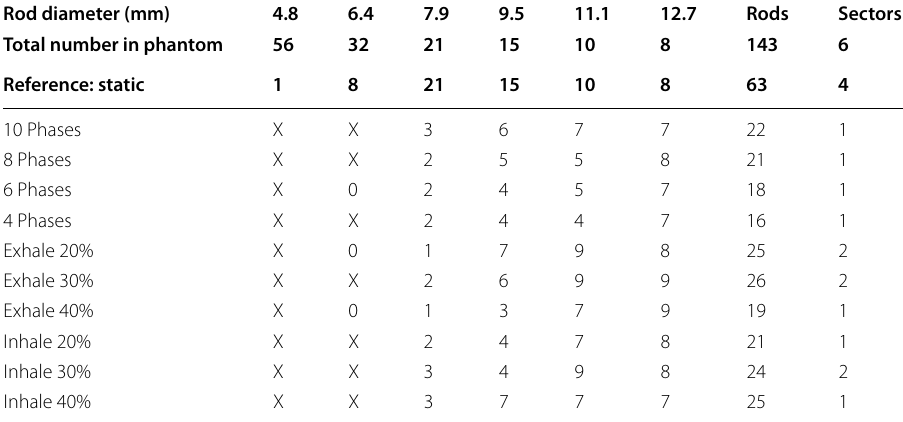
Segmentation failure marked with an X